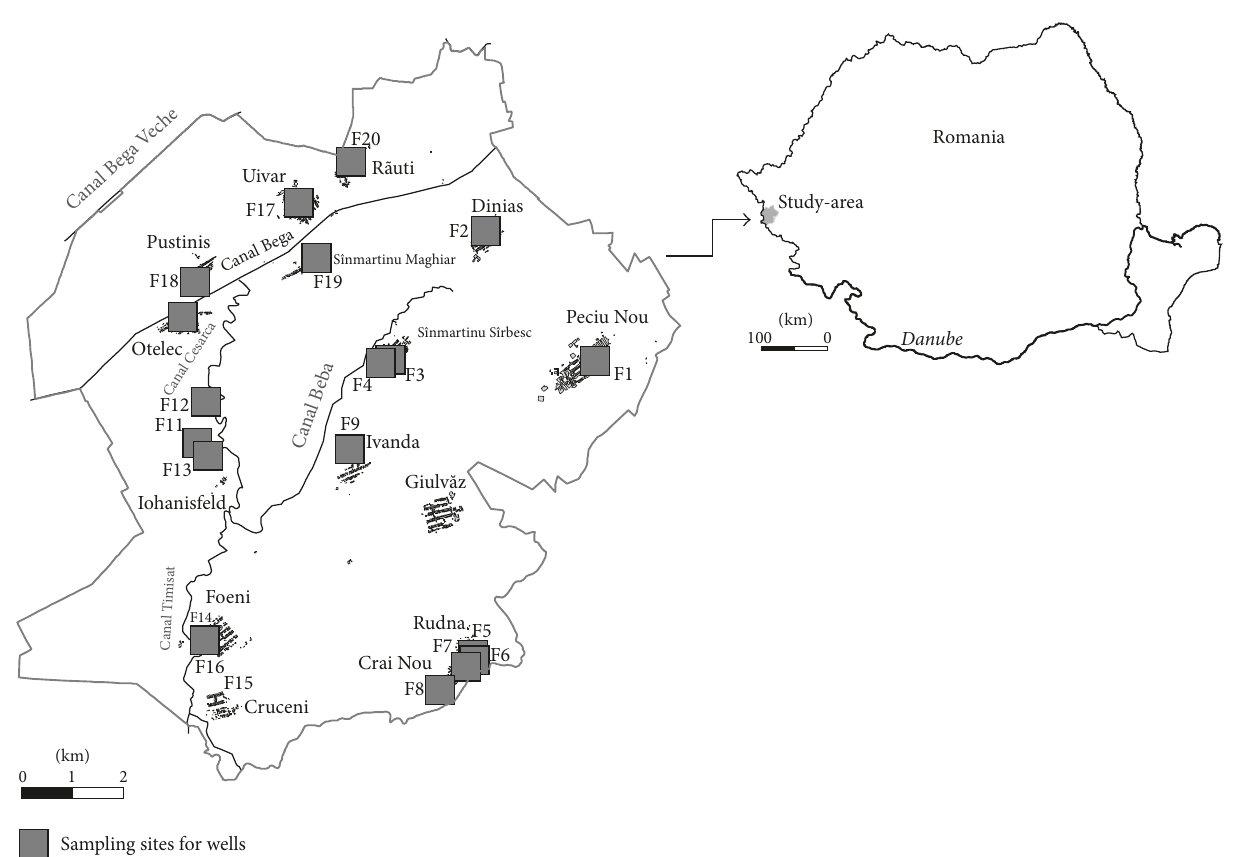
Figure 1: Location of the study area in Romania and the sampling